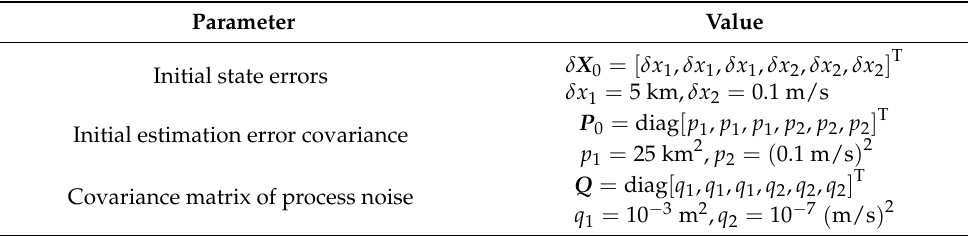
Table 2. Filter Table 2. Filter Parameters.